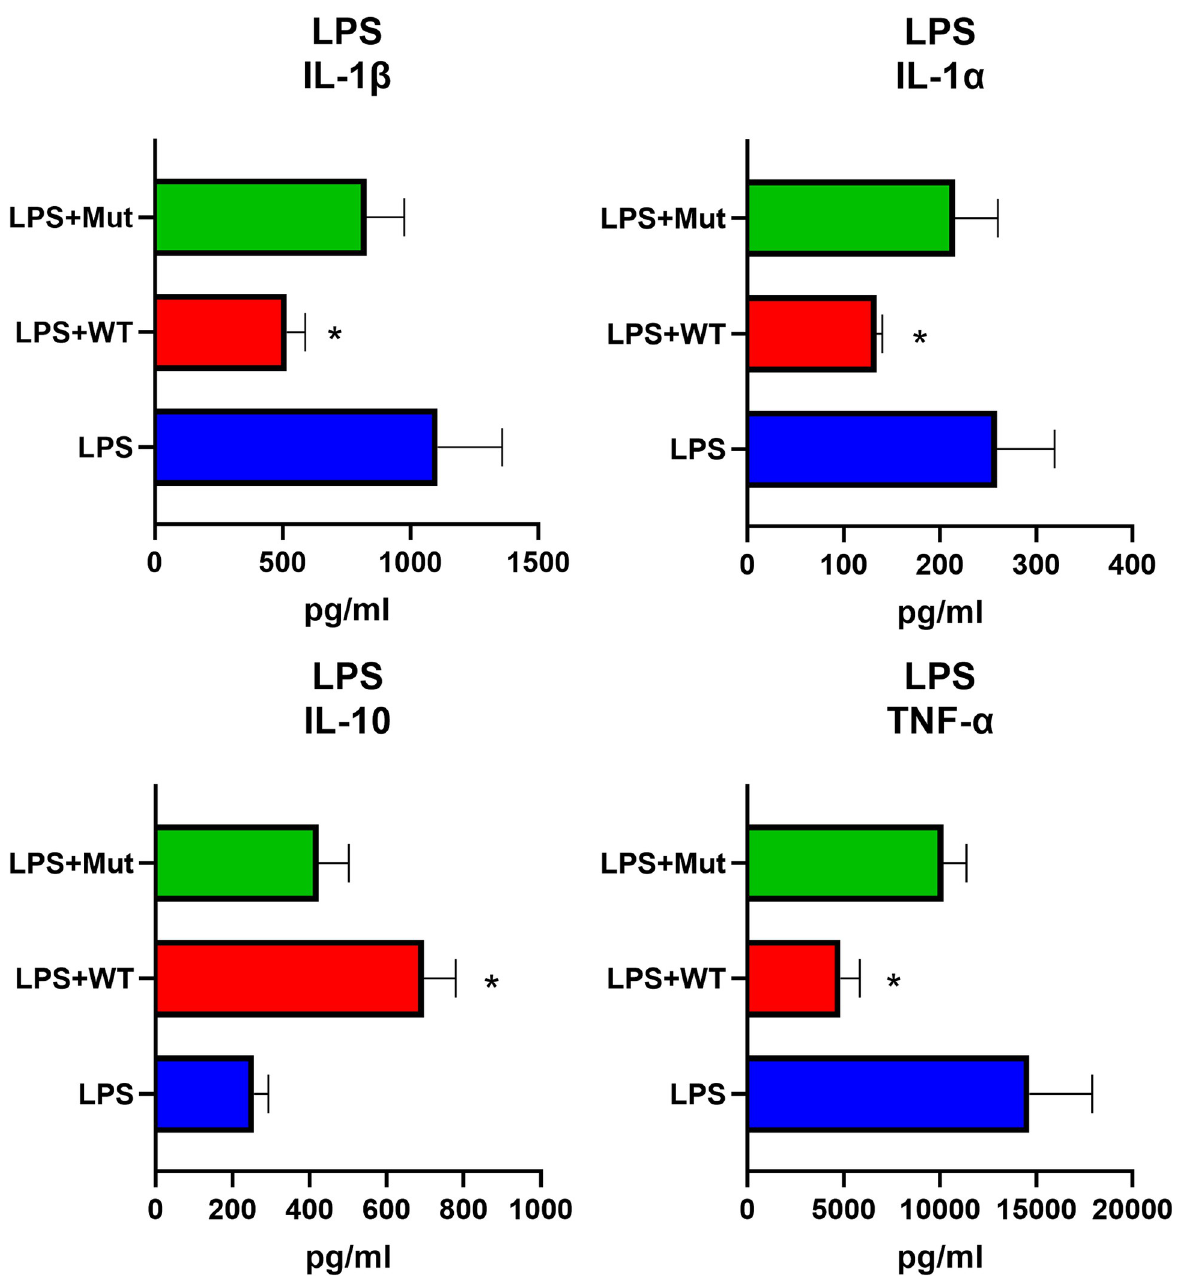
Fig 7. SmCI-1 alters cytokine profiles in an activity dependent manner when stimulated with lipopolysaccharides. Cytokine levels from human PBMCs as measured by Luminex panel presented in pg/ml. Differences in levels of key cytokines stimulated with 1 μ g/ml lipopolysaccharides (LPS). Treatments with 2 μ g/ml of either wild type rSmCI-1 (WT) or mutant rSmCI-1 (Mut) effects levels of these cytokines. ( � ) Indicates significant differences between the treatment and either the WCL control or untreated negative control. (n = 3). levels were significantly reduced via the addition of function rSmCI-1 (p < 0.05), but not rSmCI- 1Mut. IL-10 increases were also seen when adding either recombinant to LPS stimulated cells. These increases were all statistically significant, with the exception of LPS+rSmCI-1Mut (p = 0.057).